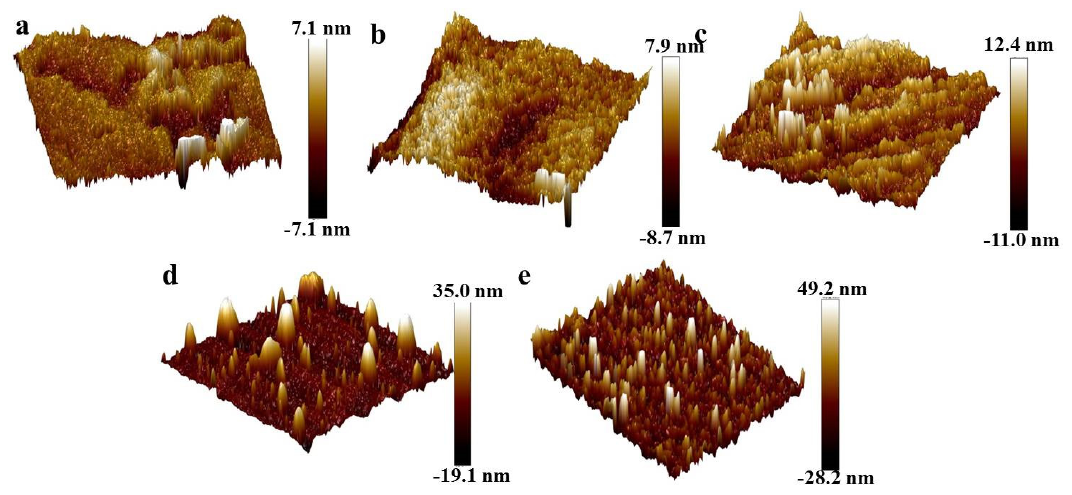
Figure 13. AFM images of oil-wet calcite modified with ( a ) CTAB, ( b ) SDS, ( c ) TX-100, ( d ) sophorolipid, and ( e ) rhamnolipid.